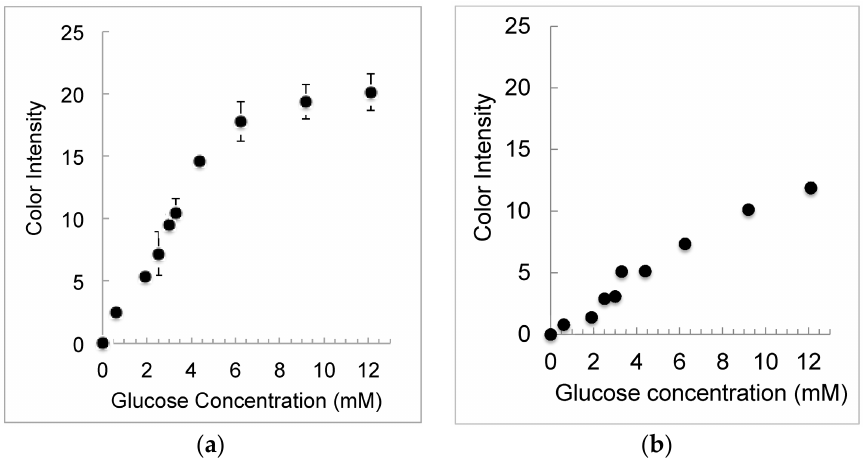
Figure 3. ( a ) Saturation curve of average yellow intensity as a function of glucose concentration for the cloverleaf chip. The error bars represent the relative standard deviation of three independent measurements; ( b ) Saturation curve of average yellow intensity as a function of glucose concentration for the shamrock chip. The error bars represent the relative standard deviation of three independent measurements.